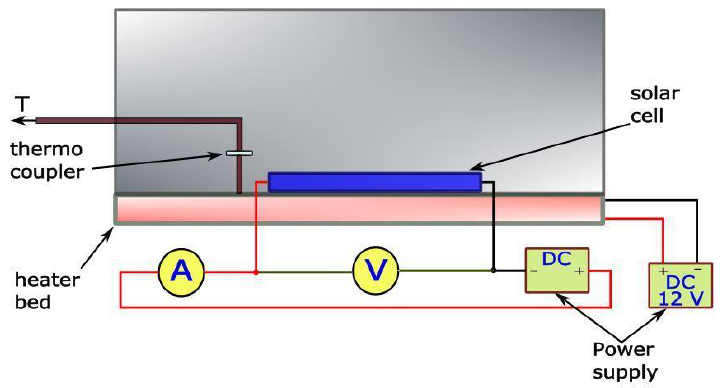
Figure 4. Diagram of the experimental setup for obtaining dark characteristics of a solar cell.